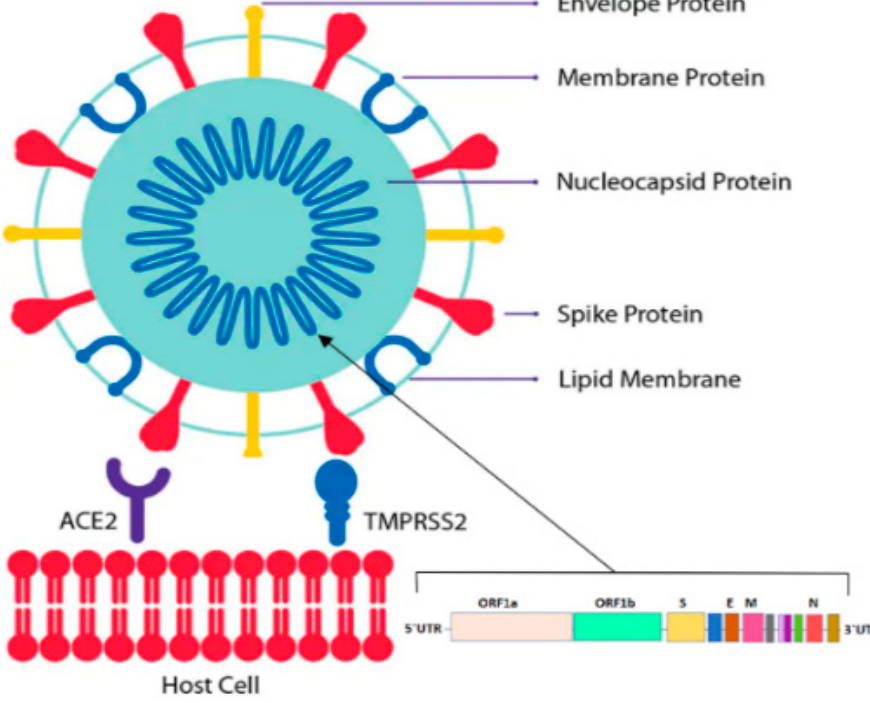
Figure 1. SARS-CoV-2 structure, binding and entry in the host. ACE2 and TMPRSS2 are the main determinants of entry. S protein uses ACE2 for binding and TMPRSS2 for its activation.